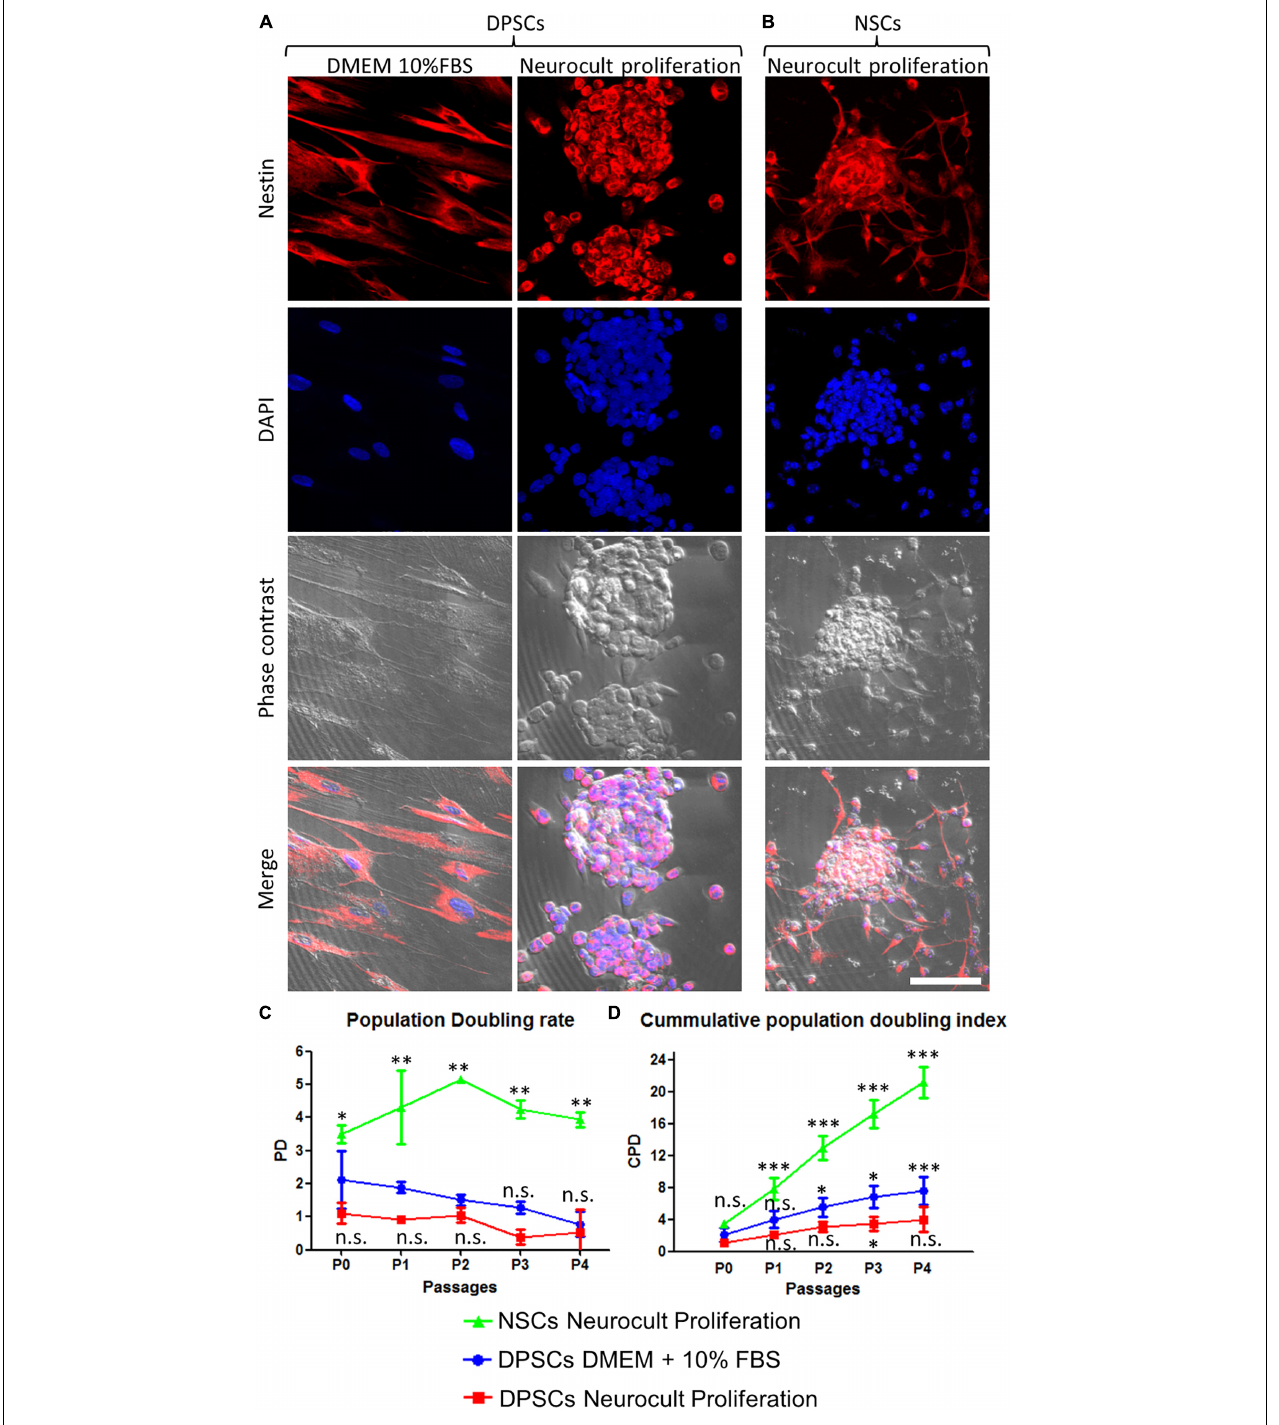
FIGURE 1 | Human DPSCs grown in Neurocult proliferation culture media generate dentospheres similar to neurospheres from murine neural stem cells (NSCs). (A) Human DPSCs seeded in standard culture DMEM + 10% FBS acquire a flat morphology and adhere to the flask surface. However, when cultured with Neurocult proliferation media, DPSCs start to grow forming free-floating dentospheres. (B) Control neurospheres of murine NSCs. All cells are positive for the neural stem/progenitor marker Nestin. (C) Population doubling rates for human DPSCs grown either with DMEM + 10% FBS or Neurocult proliferation compared with murine NSCs. (D) Cumulative population doubling (CPD) of DPSCs seeded in standard culture DMEM+10%FBS or Neurocult proliferation media and NSCs cultured in Neurocult proliferation media. All different cell culture conditions were assessed in parallel ( n = 3 for each) for a total of four passages and non-parametric Kruskal–Wallis with post hoc test was used (mean ± SD of two independent experiments ∗ p < 0.05, ∗∗ p < 0.01, and ∗∗∗ p < 0.001). Scale bar 75 µ m.